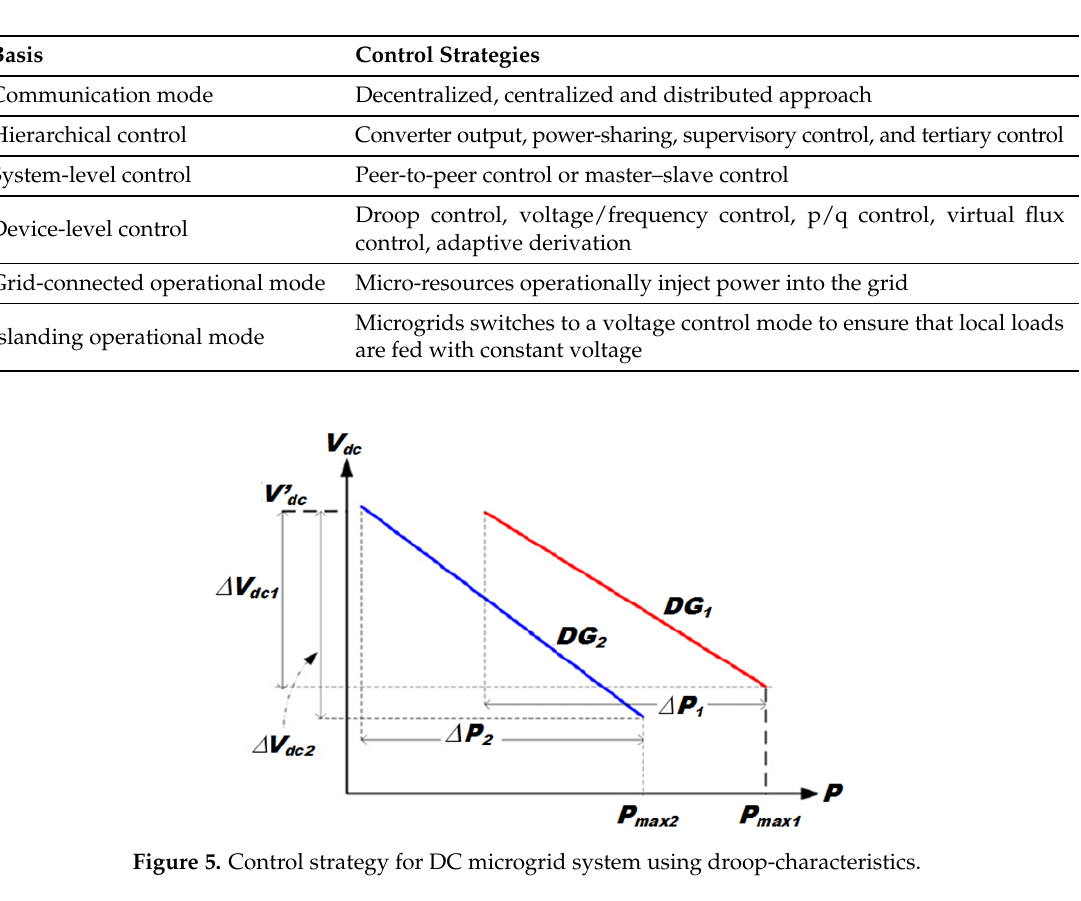
Table 2. Categorization of the control strategies.